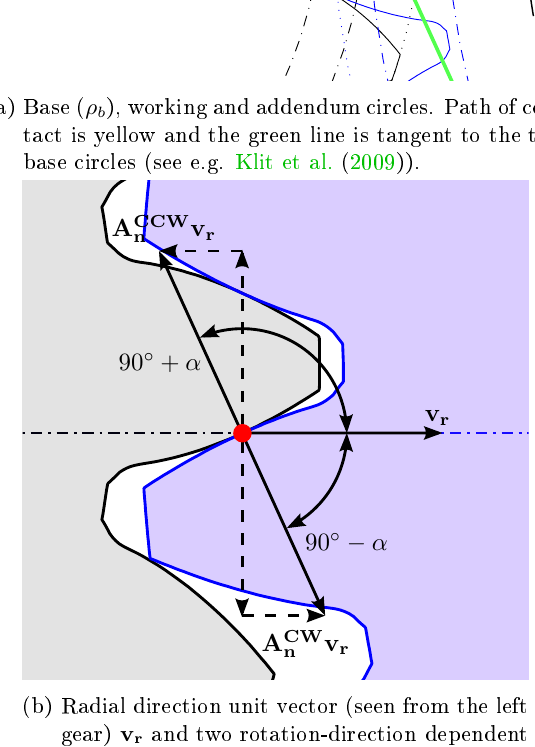
(b) Radial direction unit vector (seen from the left gear) v r and two rotation-direction dependent unit vectors A n v r (CW/CCW). Figure 3: Illustration of gear tooth force components F n , F r and F t , pressure angle α